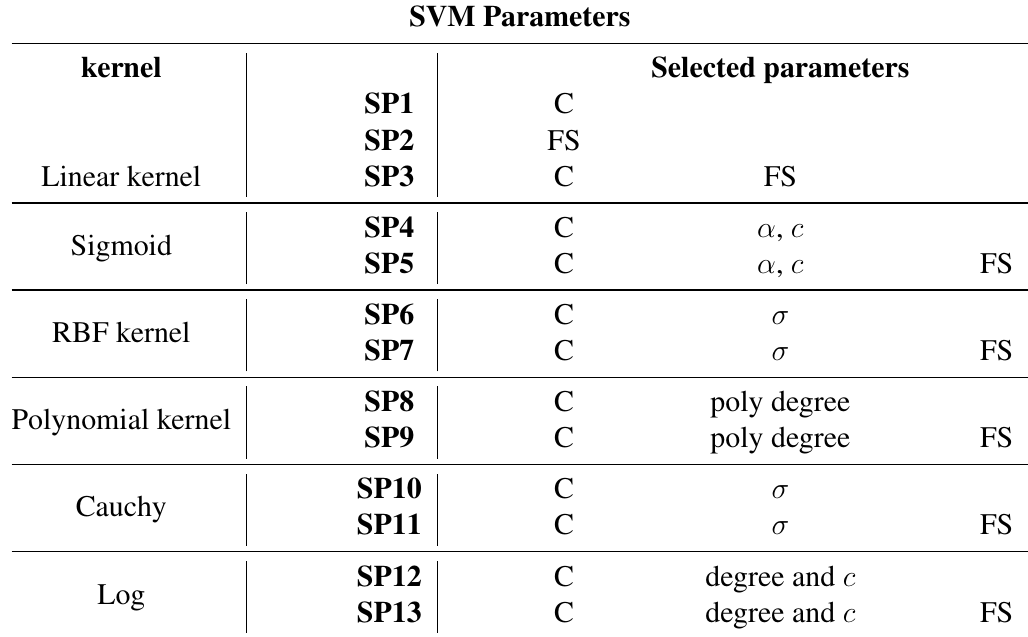
Table 2: Used combinations of selected parameters (SP i ). C is the SVM penalty weight; FS stands for feature selection; the (cid:27) , (cid:11) , c , and degree are kernel parameters.